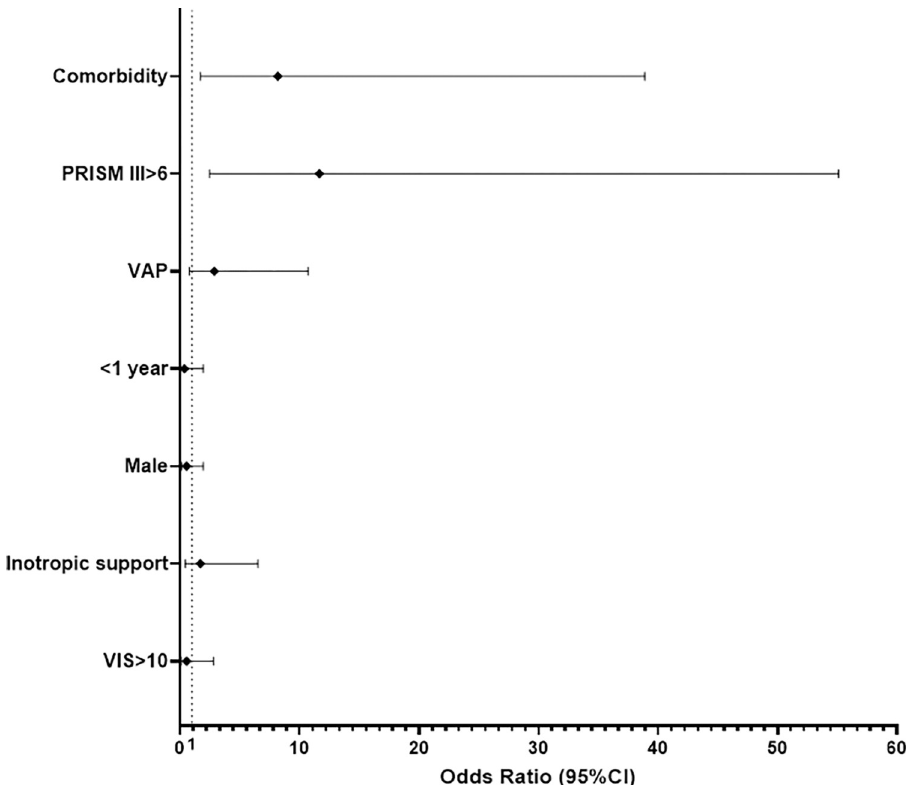
Fig 2. Forest plot representing the variables introduced in the multivariate model to detect independent risk factors for mortality. Cut-off points for continuous variables determined using Receiver Operating Characteristic curves: Paediatric risk of mortality score (PRISM III) > 6 (Sn 84.6%, Sp 69.4%), Vasoactive inotropic score (VIS) (Sn 88.9%, Sp 34.2%).